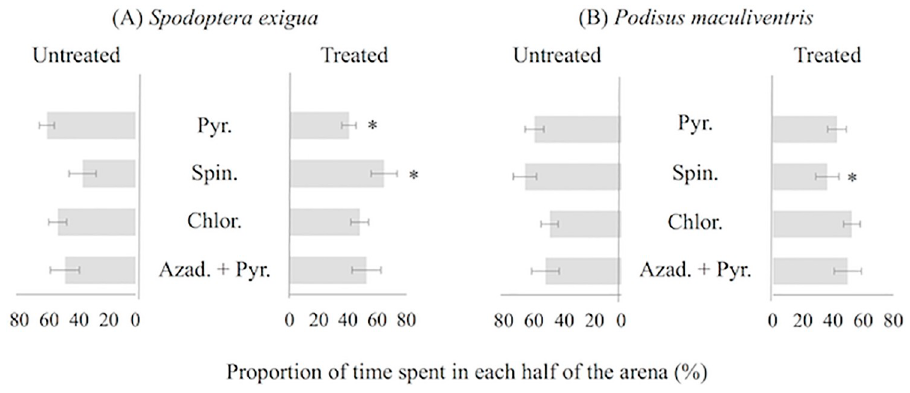
Fig 1. Time proportion (mean ± SE) spent per 3 rd instar individual beet armyworm, Spodoptera exigua (A) and spined soldier bug, Podisus maculiventris (B) for 10-minute exposures to both the treated and untreated half of the Petri dishes (9 cm diameter) lined with filter paper treated with dried insecticide residue. Asterisk in the bar indicates difference between Petri dishes treated or not with insecticide (paired Student’s t test at P <